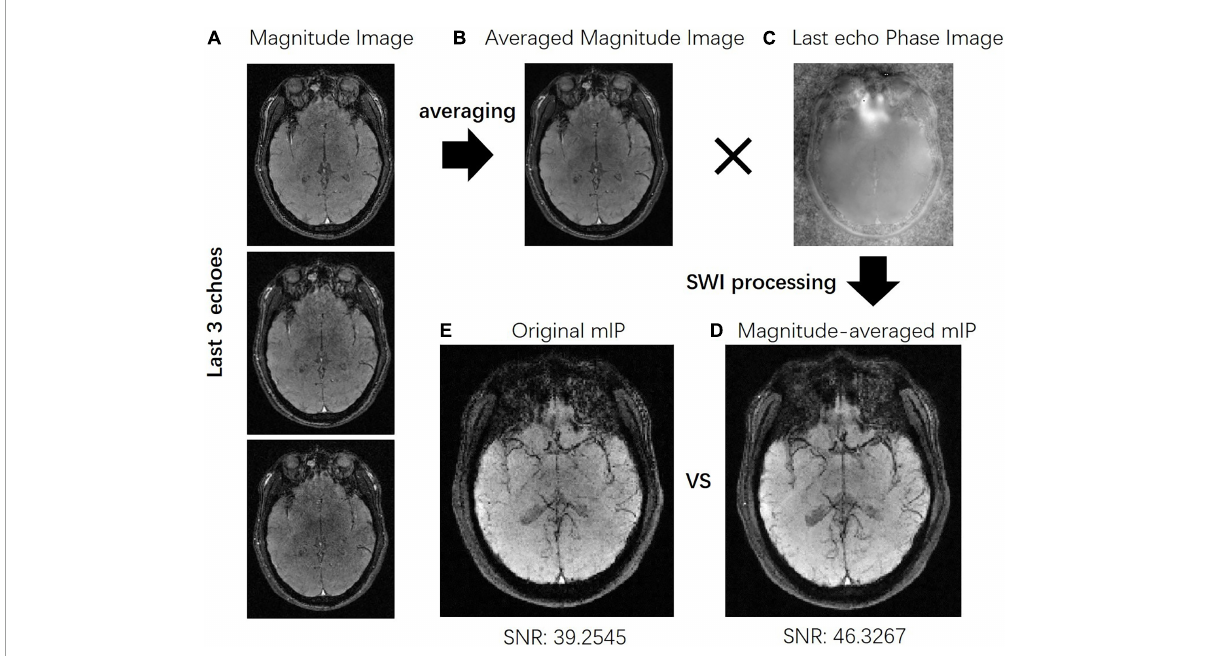
FIGURE3 (A) The last three-echo magnitude images with TE = 60, 70, and 80 ms, were chosen to be averaged. (B) The averaged magnitude image. (C) The phase image of the last echo acquisition with TE of 80 ms. (D) The averaged magnitude image and the phase image of the last echo were applied to the susceptibility weighted imaging (SWI) processing to improve the signal-to-noise ratio (SNR) of the result. (E) The original SWI mlP result with a lower